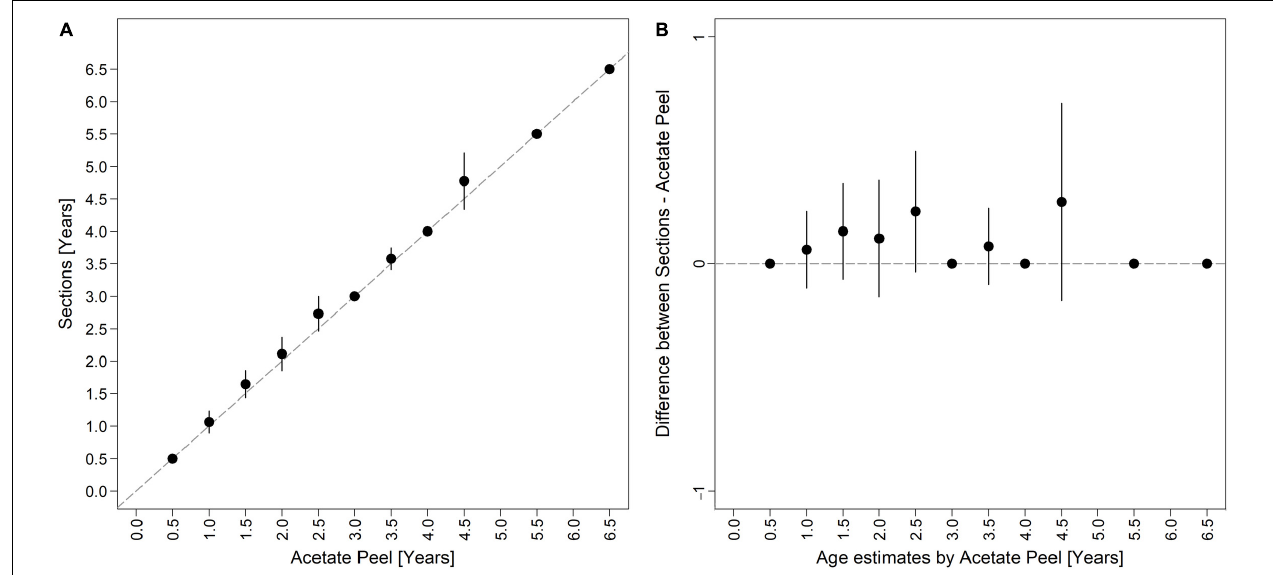
FIGURE 6 | Bias plot comparing (A) differences in age readings between the two shell sectioning techniques as described by Campana et al. (1995), and (B) the differences between thin sections and acetate peels readings versus the acetate peels age estimates as described by Muir et al. (2008).